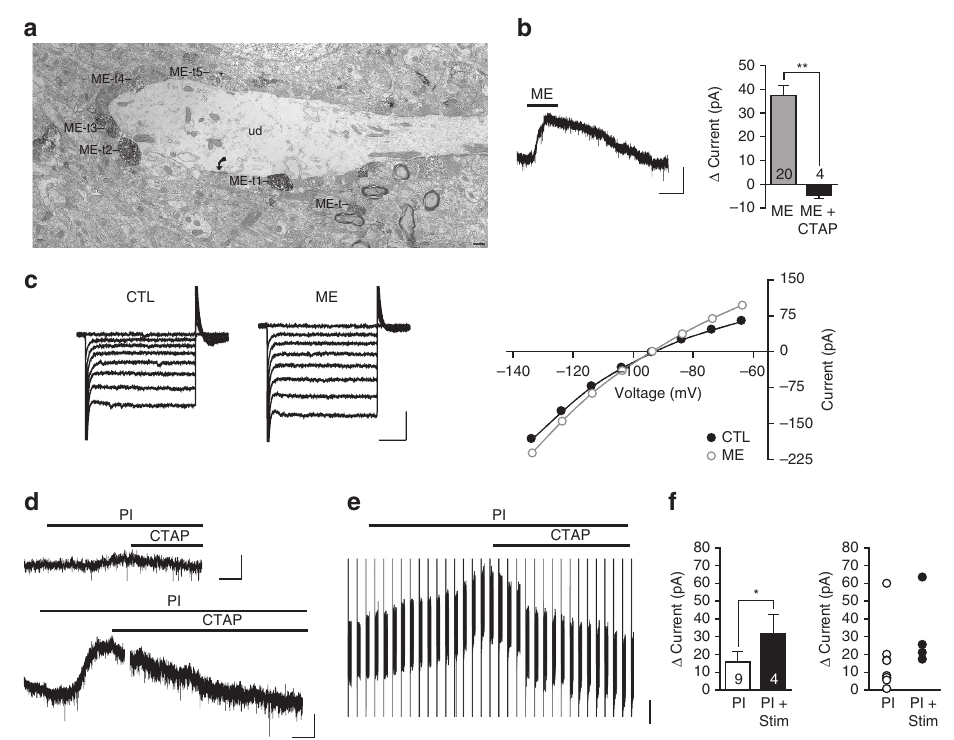
Figure 5 | Endogenously released opioids activate a postsynaptic conductance in ITC neurons. ( a ) ME-ir axon terminals converge onto a single postsynaptic target. Numerous ME terminals (MEt1–5) contact an unlabeled dendrite (ud). ME immunoperoxidase reactivity was observed in axon terminals across a spectrum of density and localization ranging from densely filling the entire terminal (ME-t1–3), to diffuse localization within a terminal (MEt4), to discrete compartmentalization in dense core vesicles (ME-t5). ME-ir terminals (ME-t) were also observed elsewhere in the field. Curved arrow indicates an asymmetric synapse. Scale bar, 500nm. ( b ) ME rapidly activates an outward current in ITC neurons through MOR. Example current trace showing ME (30 m M) and rapid washout. Bar chart showing outward current amplitude is blocked by CTAP (1 m M, * P o 0.05, paired t -test). ( c )